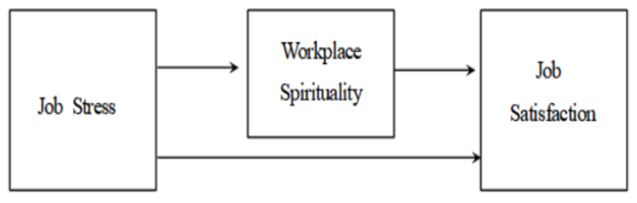
Figure 1. Conceptual framework.